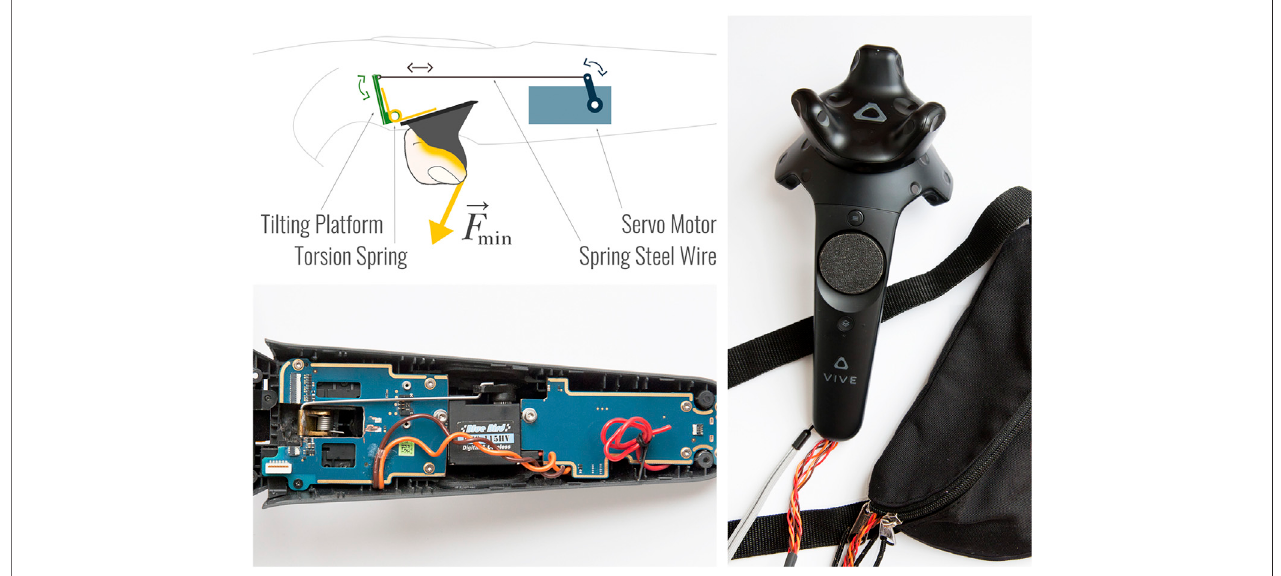
FIGURE3|(topleft) Schematicillustrationofthespringmechanismofourprototypeutilisingatorsionspring. (bottomleft) Springmechanismembeddedintothe casing of an HTC Vive controller. (right) Our prototype for adaptive trigger resistance. Electrical components are connected via cable to the prototype ’ s bottom and carried in a small bag. An HTC Vive tracker attached on top ensures the spatial tracking of the device.